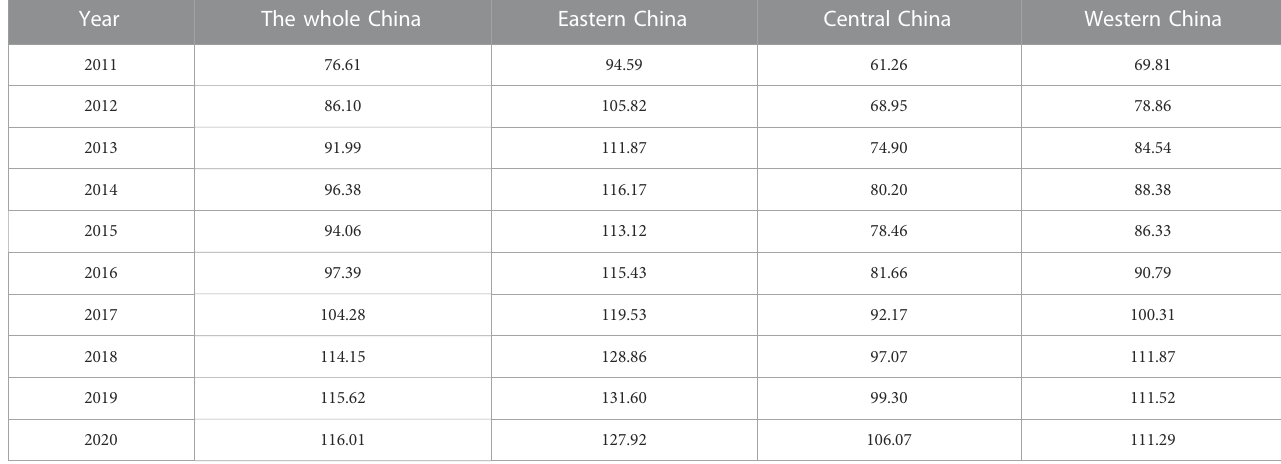
TABLE 1 The whole of China and regional the level of digital development from 2011 to 2020 Unit: The number of mobile Internet users per 100 people. Year